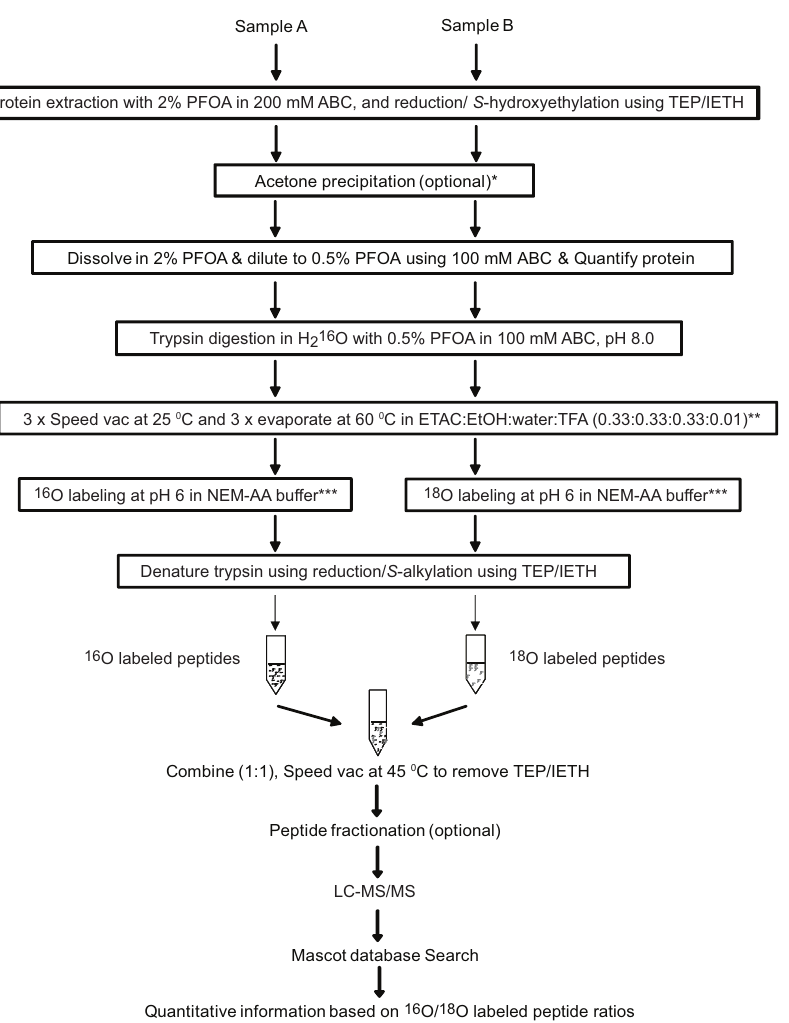
Figure 1. The proteolytic 18 O labeling procedure uses a single tube. *The photoreceptor OS membrane protein was prepared by precipitation with acetone to remove the lipids from the plasma and disc membranes, but depending on the nature of sample, this step may not be required. If acetone precipitation is not required, the excess of the TEP/IETH can be removed by speed-vac at 45 u C. ** After every reconstitution step the sample was sonicated in a water bath for 10 sec. Formic acid can also be used instead of TFA. ***100 mM ammonium formate buffer (pH 6) can also be used. TEP (triethylphosphene), IETH (iodoethanol), ABC (ammonium bicarbonate), PFOA (perfluorooctanoic acid), ETAC (ethylacetate), EtOH (ethanol), TFA (trifluoroacetic acid), and NEM-AA (n-ethyl morpholine-acetic